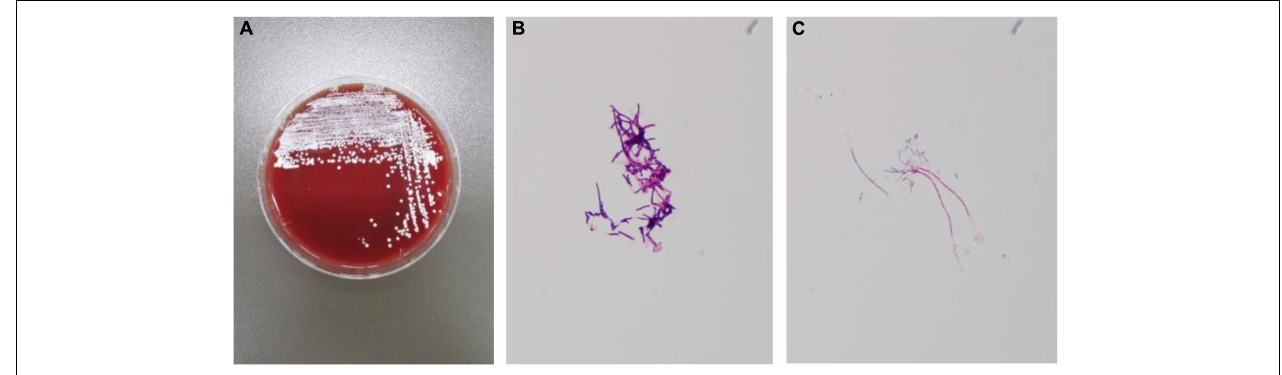
FIGURE 6 | Routine bacterial culture result: Nocardia. (A) White, unequal, wrinkling, and granular colonies were growing on the culture medium. (B) Gram-staining of bacterial cultures shows Gram-positive bacteria. (C) Weak acid-fast staining.